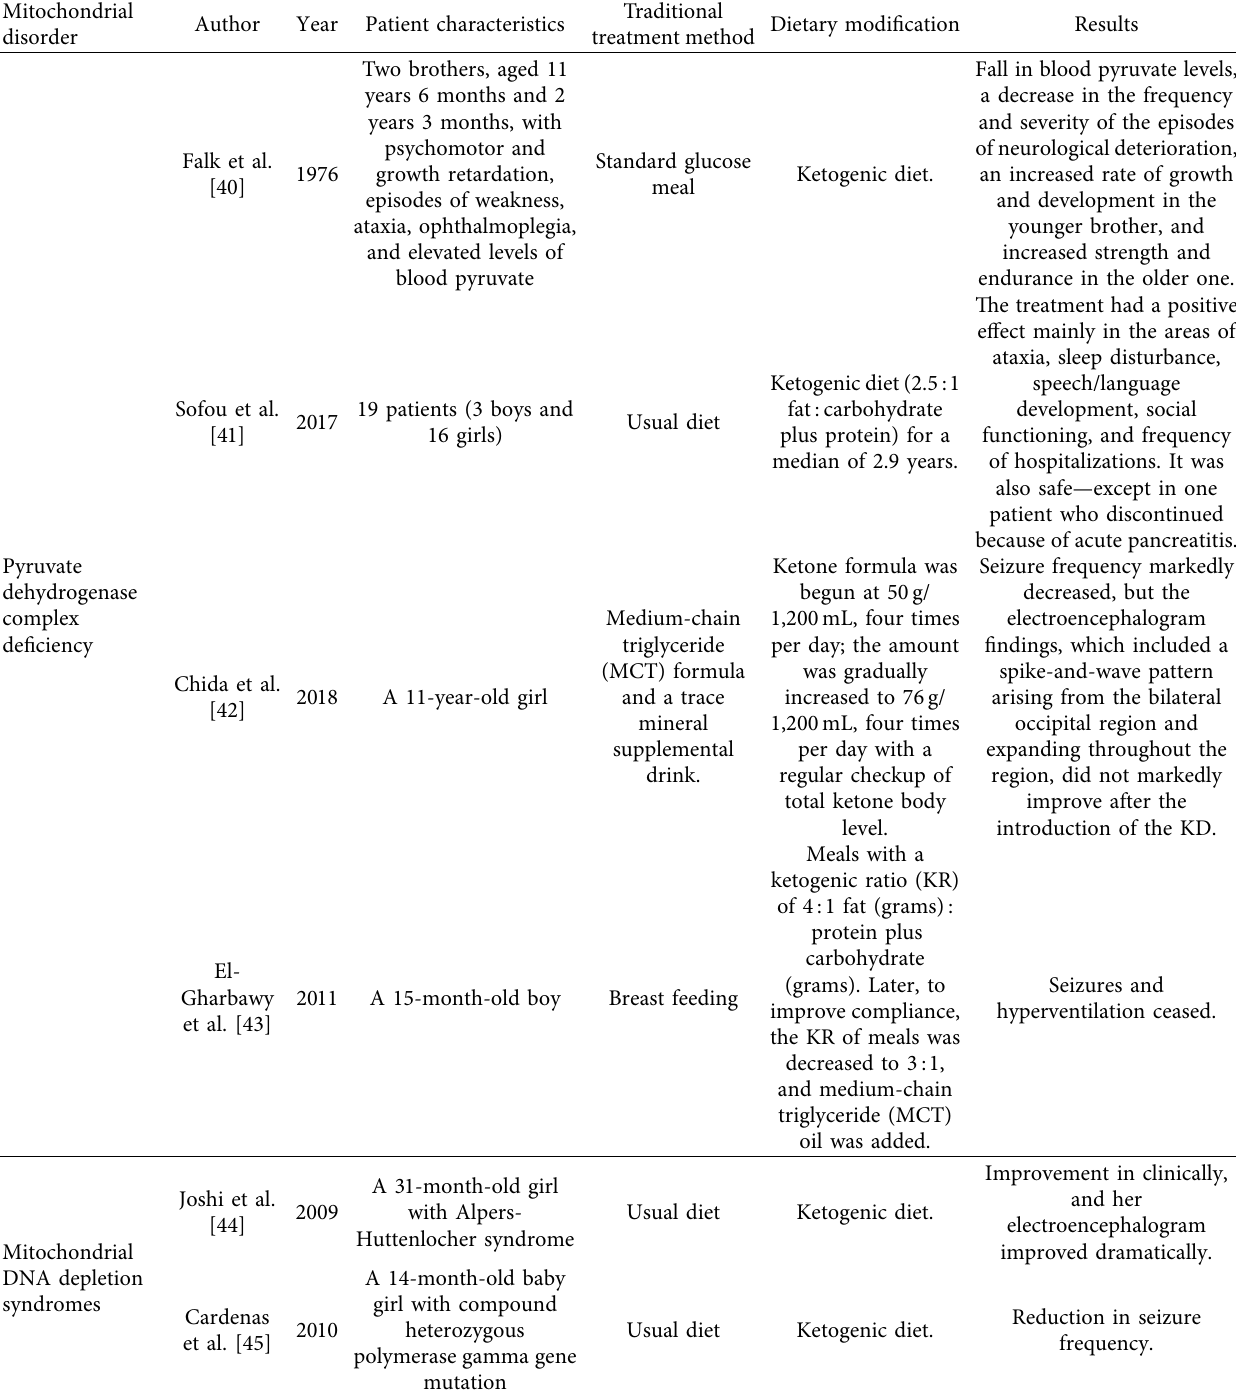
Table 4: Summary of case report and case series found in the literature regarding use of KD in mitochondrial disorders.